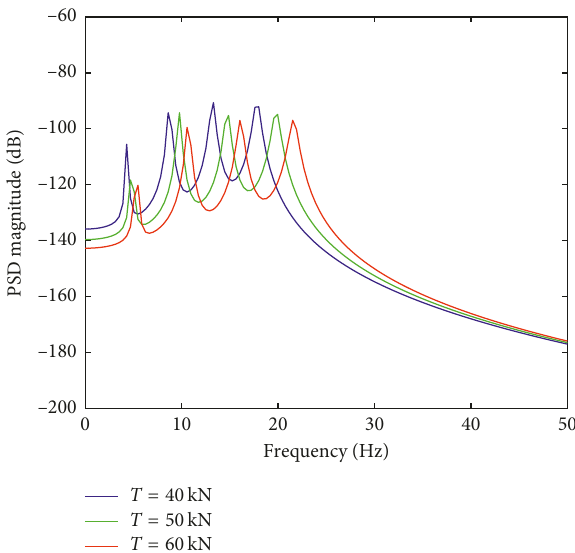
Figure 4: Analytic PSD function tension force comparison.